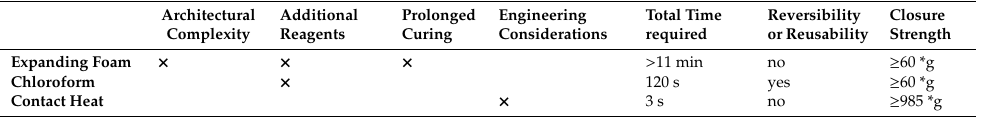
Table 1. Potential considerations for implementation of the three putative closure methods. Valve strength was evaluated by applying hydraulic pressure to attempted valve and channel closures.